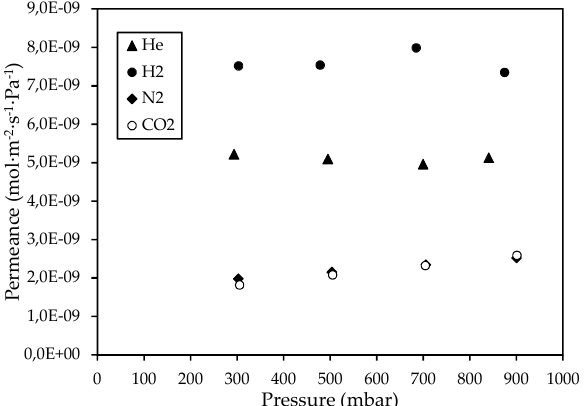
Figure 3. Permeance of He, H 2 , N 2 , and CO 2 gases through the CM_2 membrane at 90 ◦ C, with respect to the pressure.